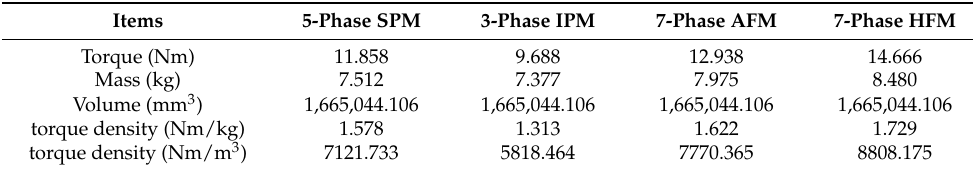
Table 6. Torque density of the four machines.